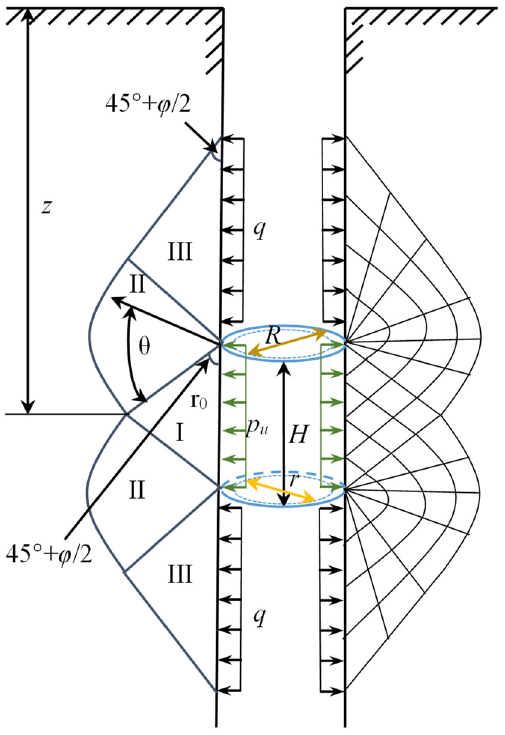
Figure 8. Schematic diagram of ultimate bearing capacity of drilling hole wall.